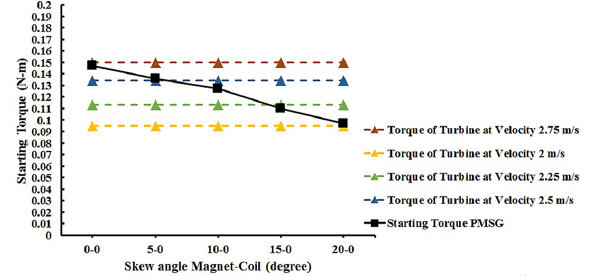
Fig. 6. Comparison between average power and rotating speed of the